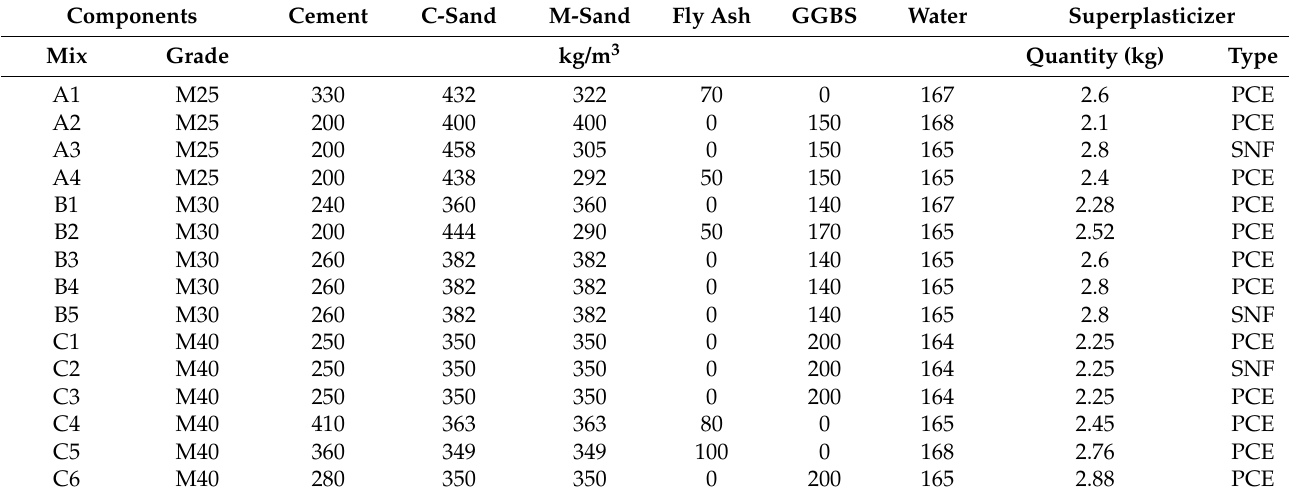
Table 5. Concrete Mix Compositions.